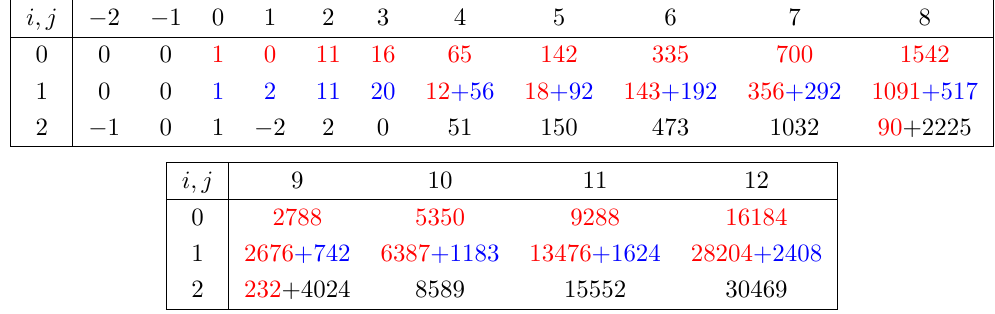
Table 14 . Unre(cid:12)ned coe(cid:14)cients c A 2